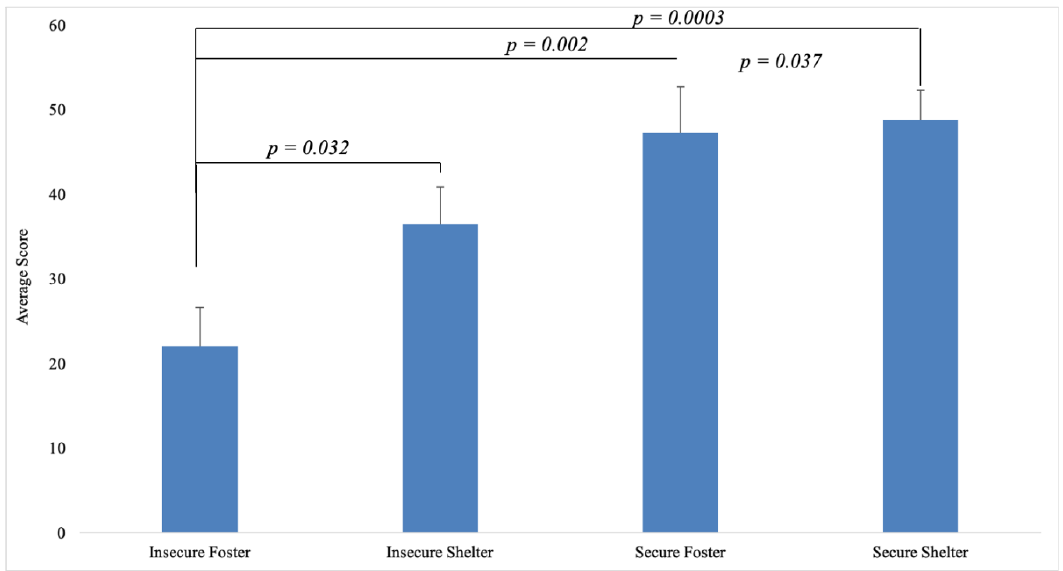
Figure 4. Mean disinhibited attachment scores for foster and shelter dogs with insecure and secure attachment styles. Error bars indicate standard error of the mean.